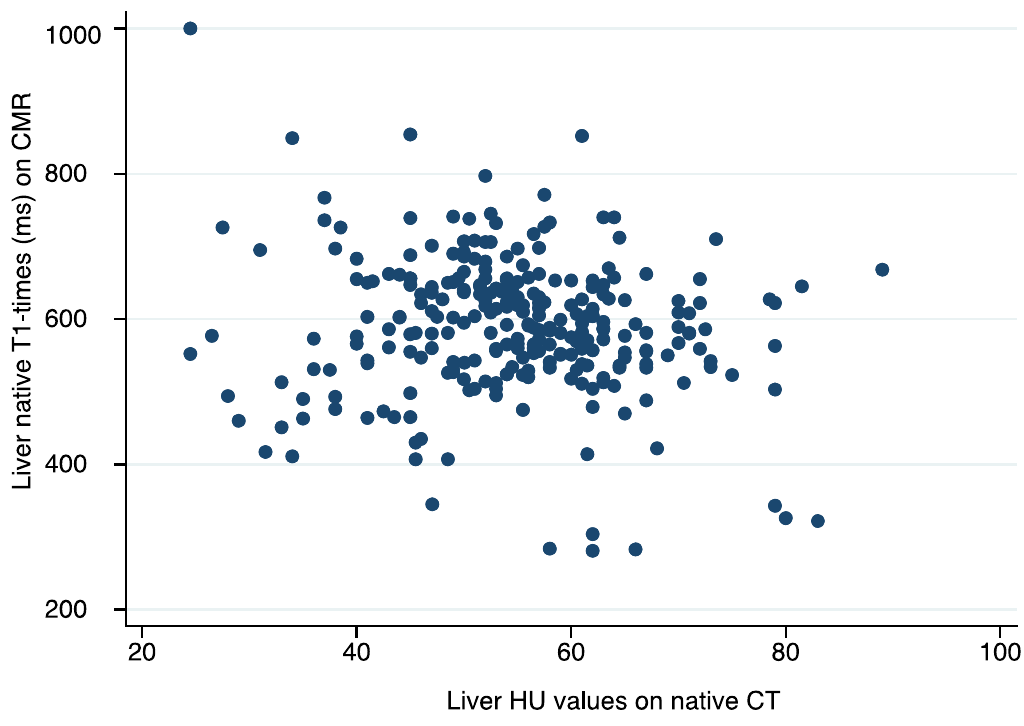
Figure 2. Scatter plot demonstrating the association between HU values on unenhanced computed tomography (CT) and native T1-times on cardiovascular magnetic resonance imaging (CMR) of hepatic tissue. Table 1. Baseline characteristics, stratified by medians of liver HU values on computed tomography and native T1-times on cardiovascular magnetic resonance